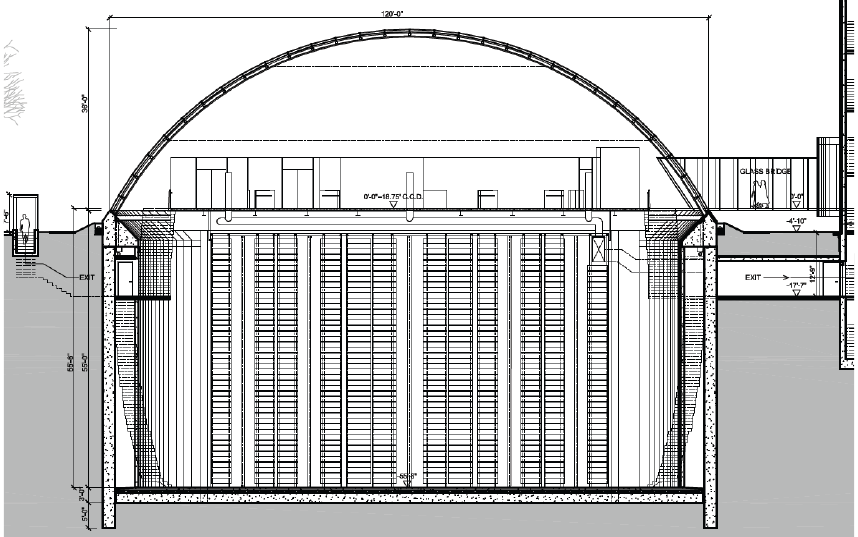
Figure 2: Vertical section (© Murphy/Jahn Architects, Chicago).